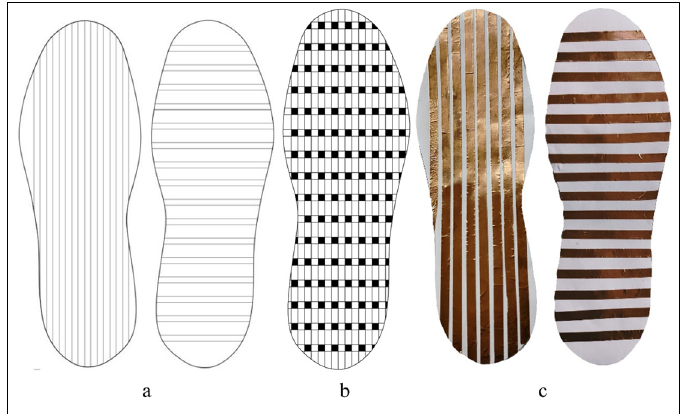
Figure 2. Sensor management: ( a ) horizontal and vertical markings; ( b ) total sensing points; ( c ) placement of copper tapes.